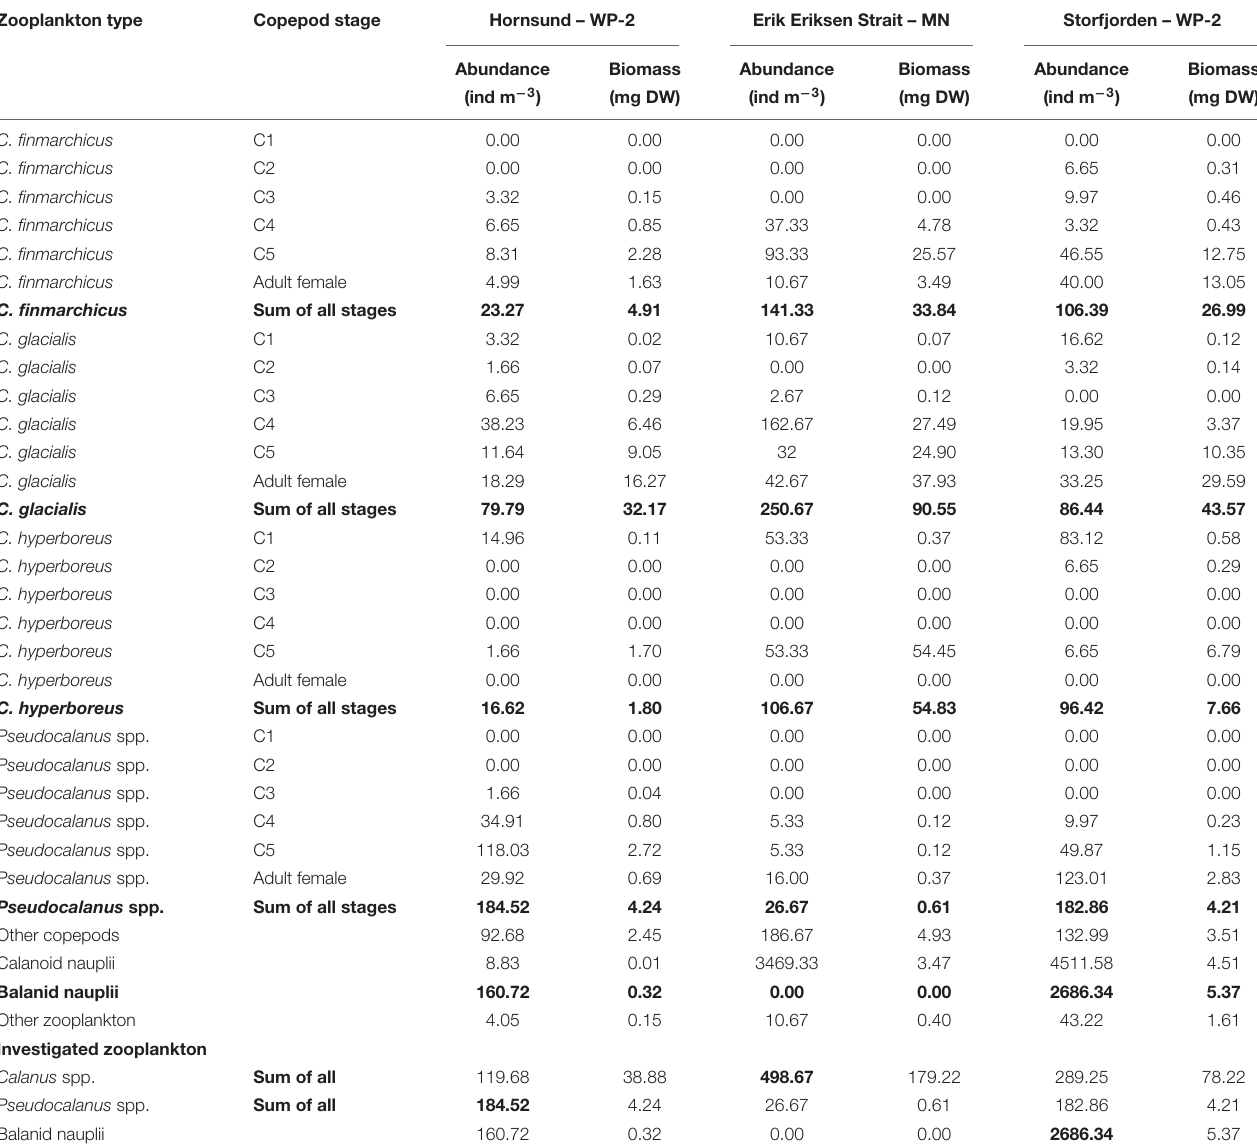
TABLE 2 | Zooplankton abundance in the upper 25 m of the water column at Hornsund, Erik Eriksen Strait, and Storfjorden. Zooplankton type Copepod